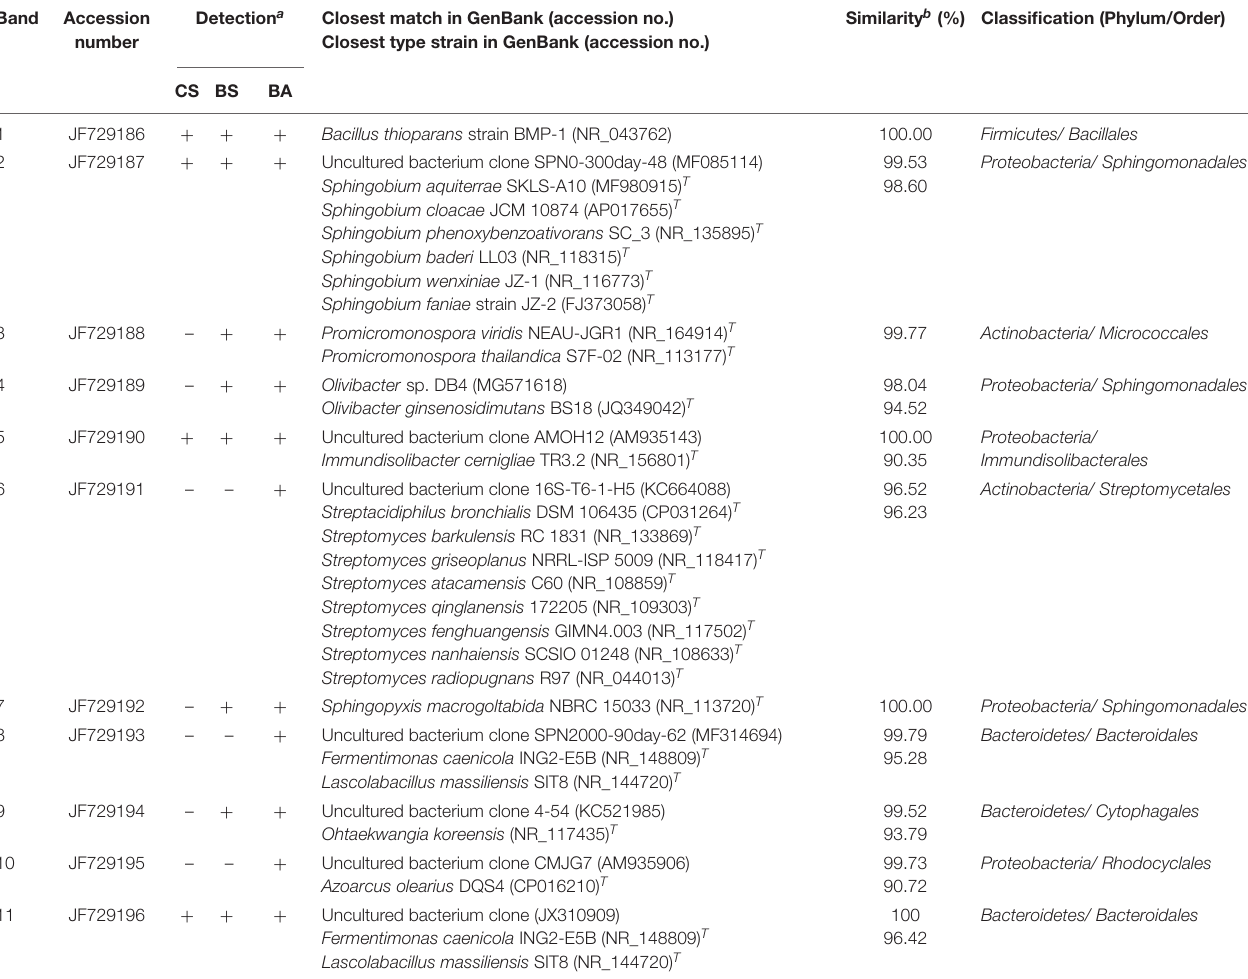
TABLE 4 | Identification of excised and amplified DGGE bands ( Figure 5 ) through nucleotide sequence BLAST to the GenBank database. Band Accession Detection number